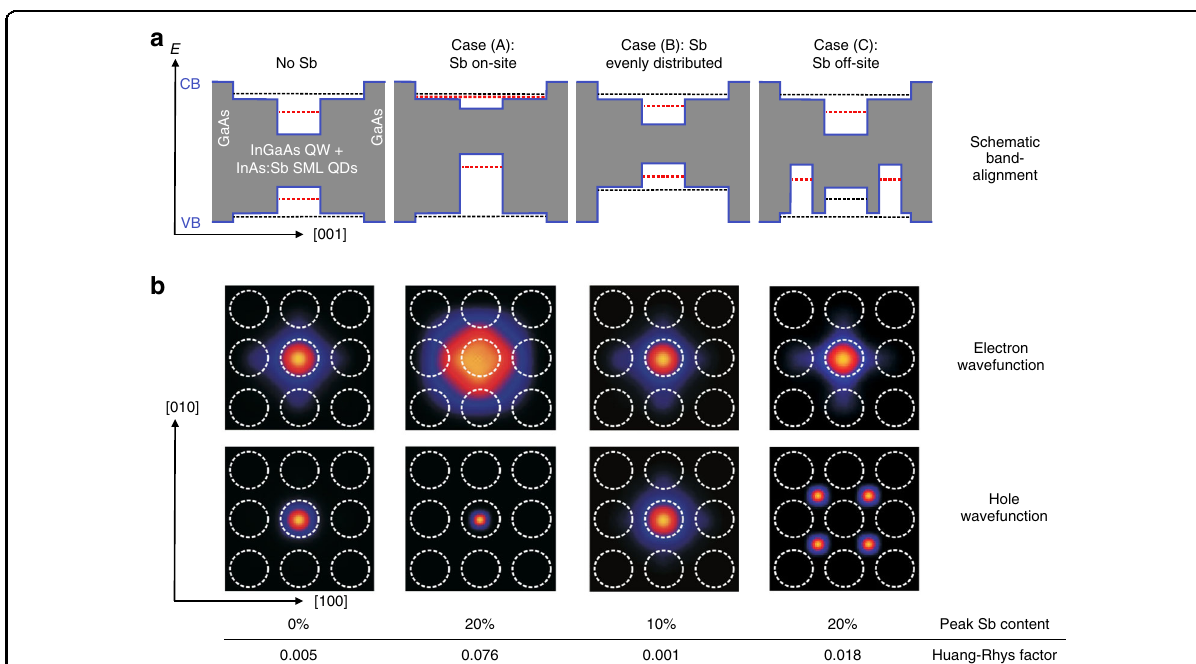
Fig. 7 a Band alignment diagram for various antimony distribution instances; dotted lines represent the energy levels of the QW and embedded QDs. b Localization of electrons and holes for varied Sb distributions. For electron – hole pairs, the Huang-Rhys factors are listed below. (reproduced from ref. 58